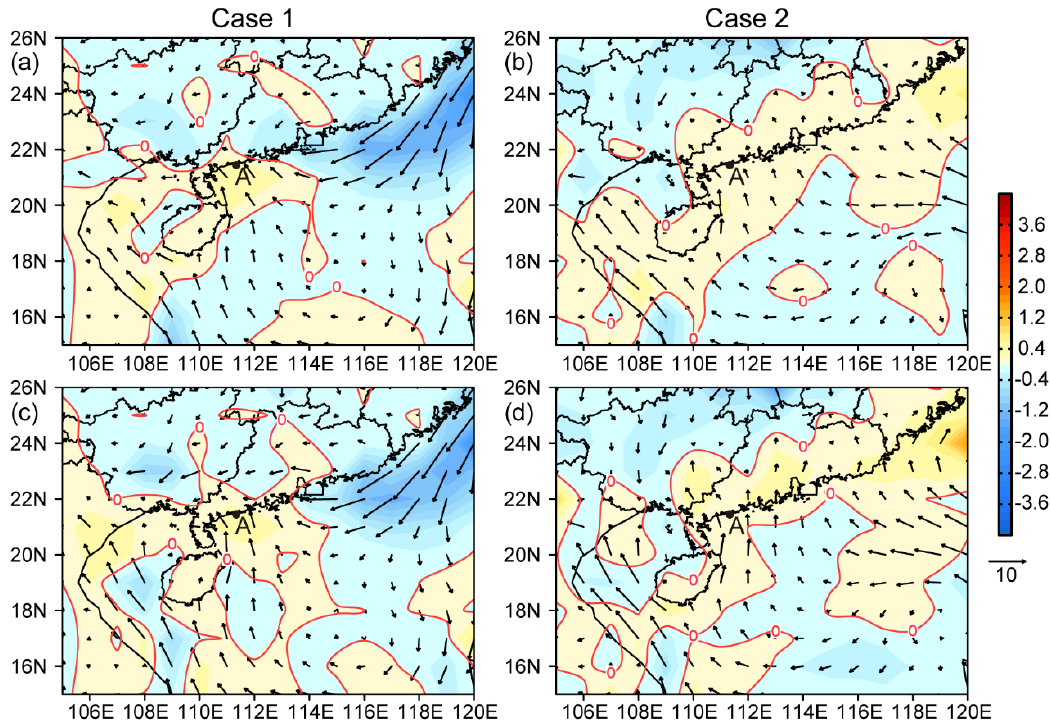
Figure 8. Same as Figure 7, except for time-average horizontal vapor transport (shaded, 10 − 4 g kg − 1 s − 1 ) and wind vectors (m s − 1 ).